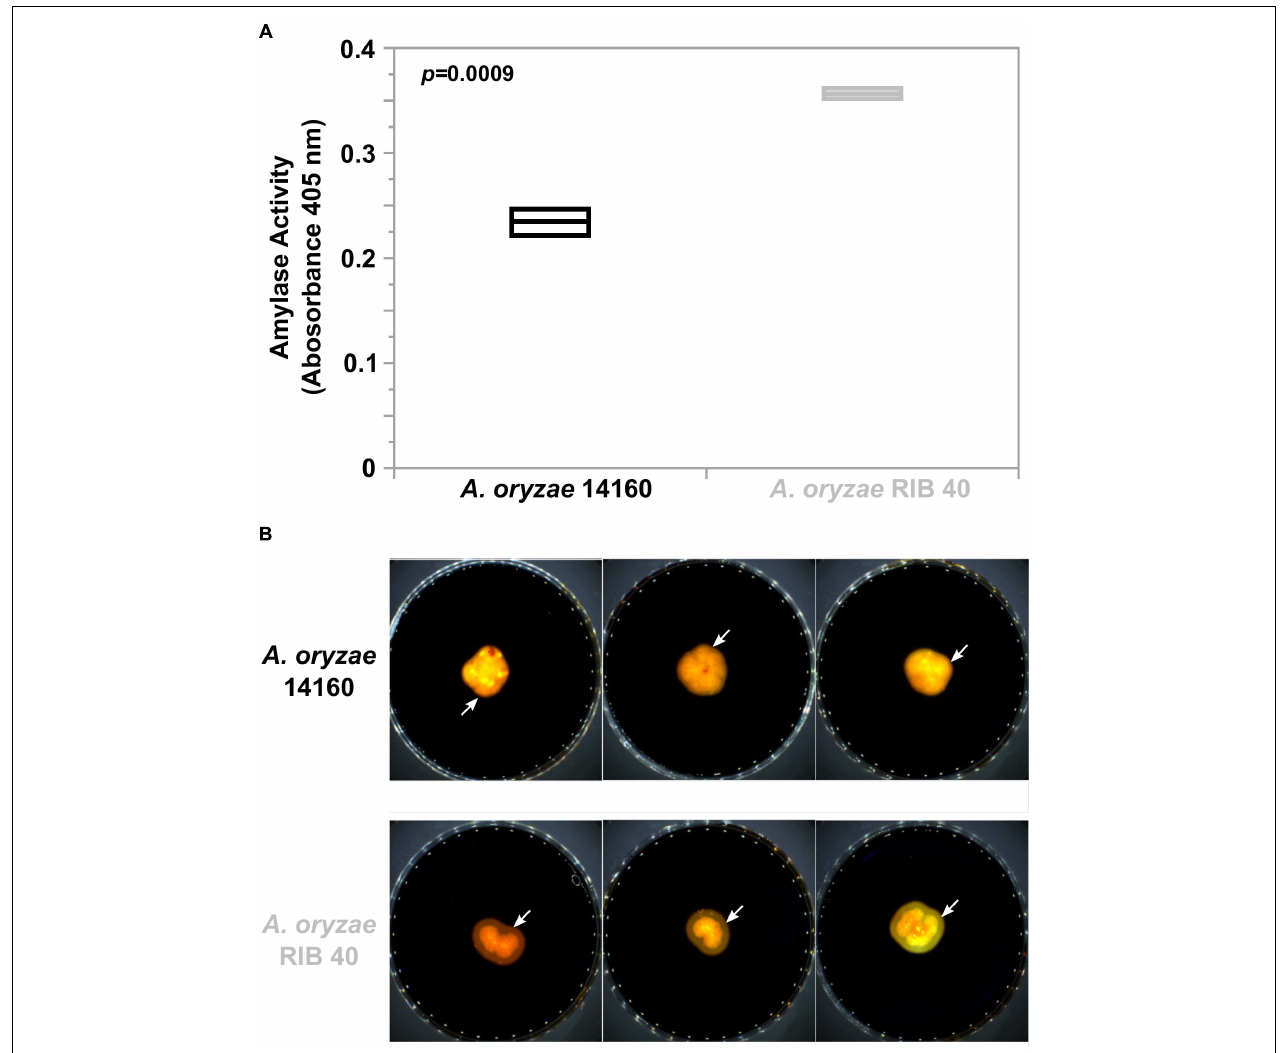
FIGURE 5 | Alpha-amylase activity in A. oryzae 14160 and RIB 40. (A) Quantitative analysis of amylase activity during solid state rice fermentation. Amylase activity was measured in triplicate using the Megazyme alpha-amylase Assay Kit. Black and Gray box plots and text represent the A. oryzae 14160 and RIB 40 isolates, respectively. (B) Qualitative iodine based amylase activity assay. Isolates were grown on starch agar and media was stained with iodine. Yellow zones surrounding the fungal colonies (white arrows) indicate amylase